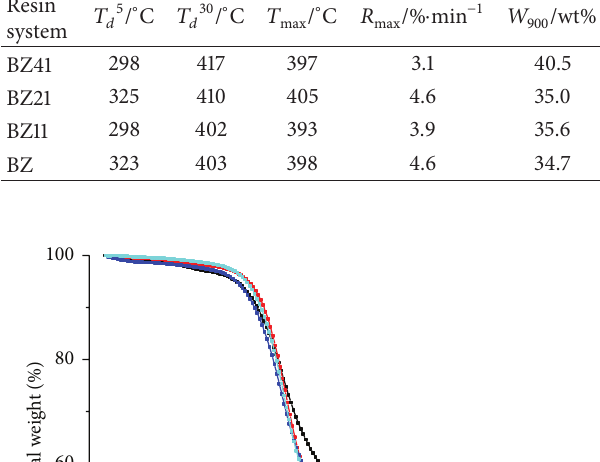
Figure 10: DTG curves of BOZ-M/F-51 hybrid